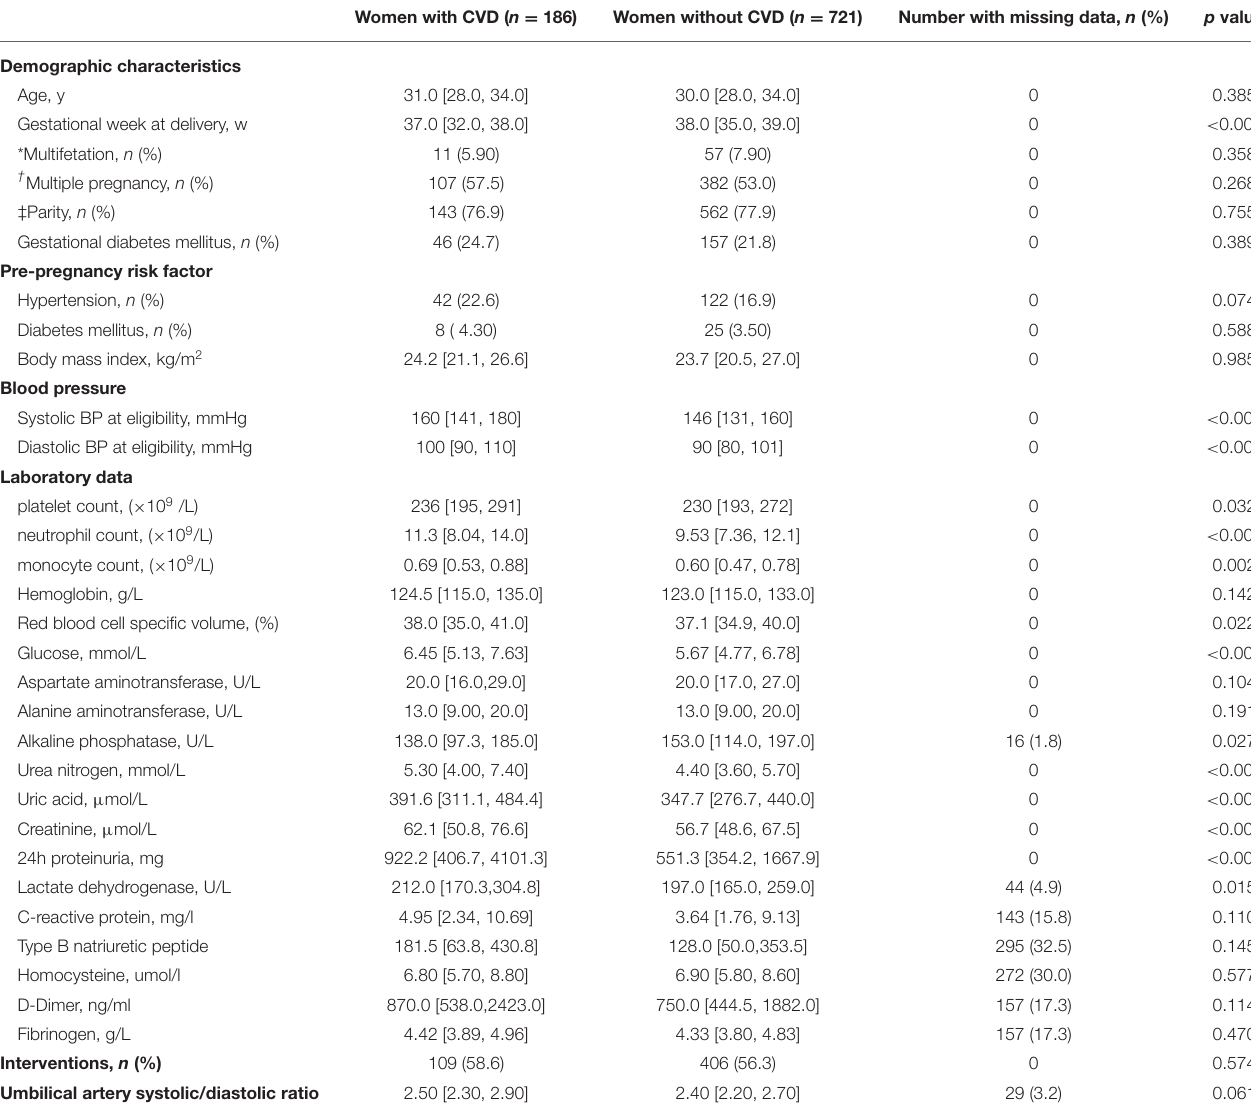
TABLE 1 | Comparison of participant characteristics by cardiovascular disease endpoints. Women with CVD ( n = 186) Women without CVD ( n = 721) Number with missing data, n (%) p